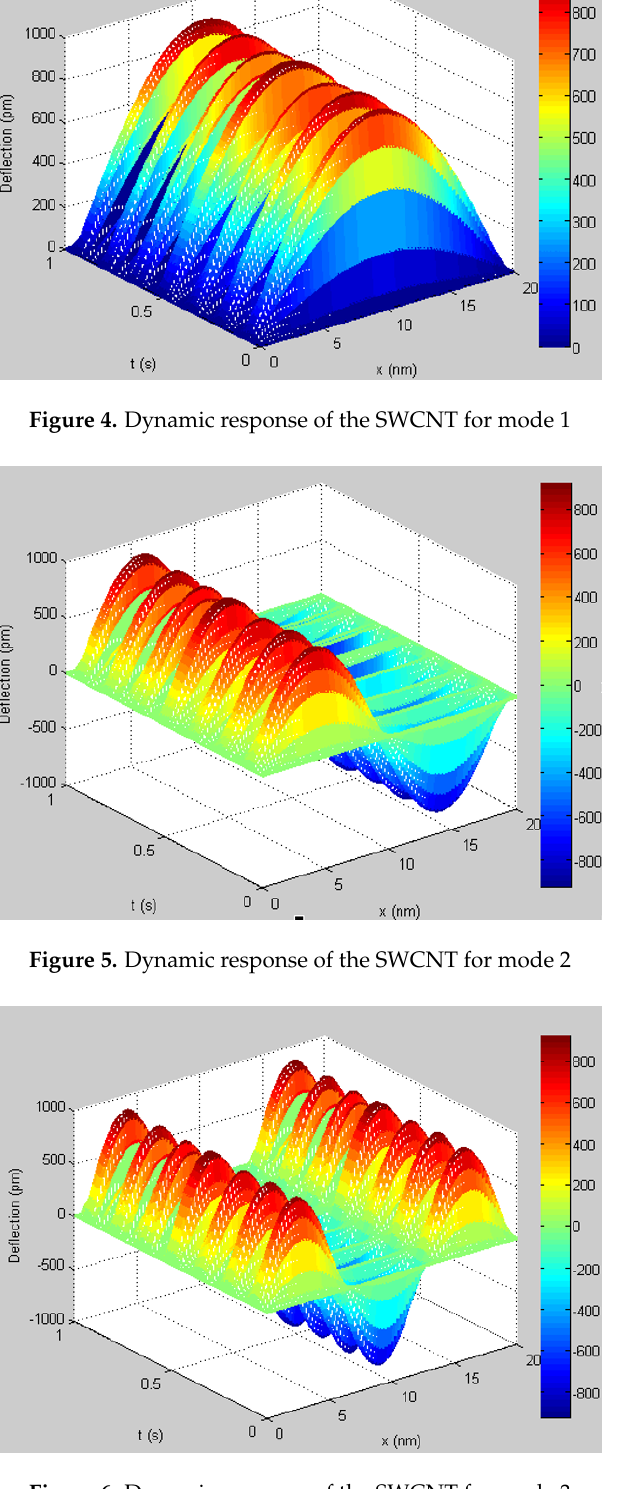
Figure 6. Dynamic response of the SWCNT for mode